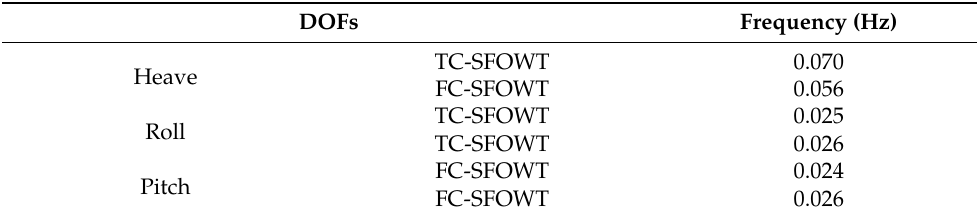
Table 6. Natural frequencies in 3 DOFs of the SFOWTs.